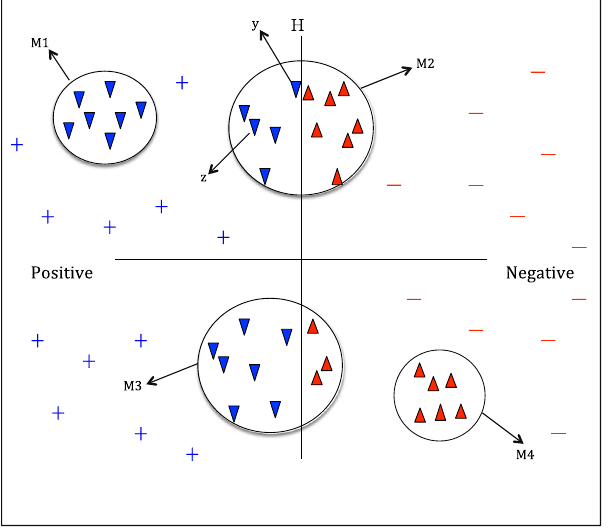
Figure 11. Computing the local similarity weights of the ambiguous samples. Blue lower triangles represent positive DTI samples in a cluster, red upper triangles represent NDTISs in the